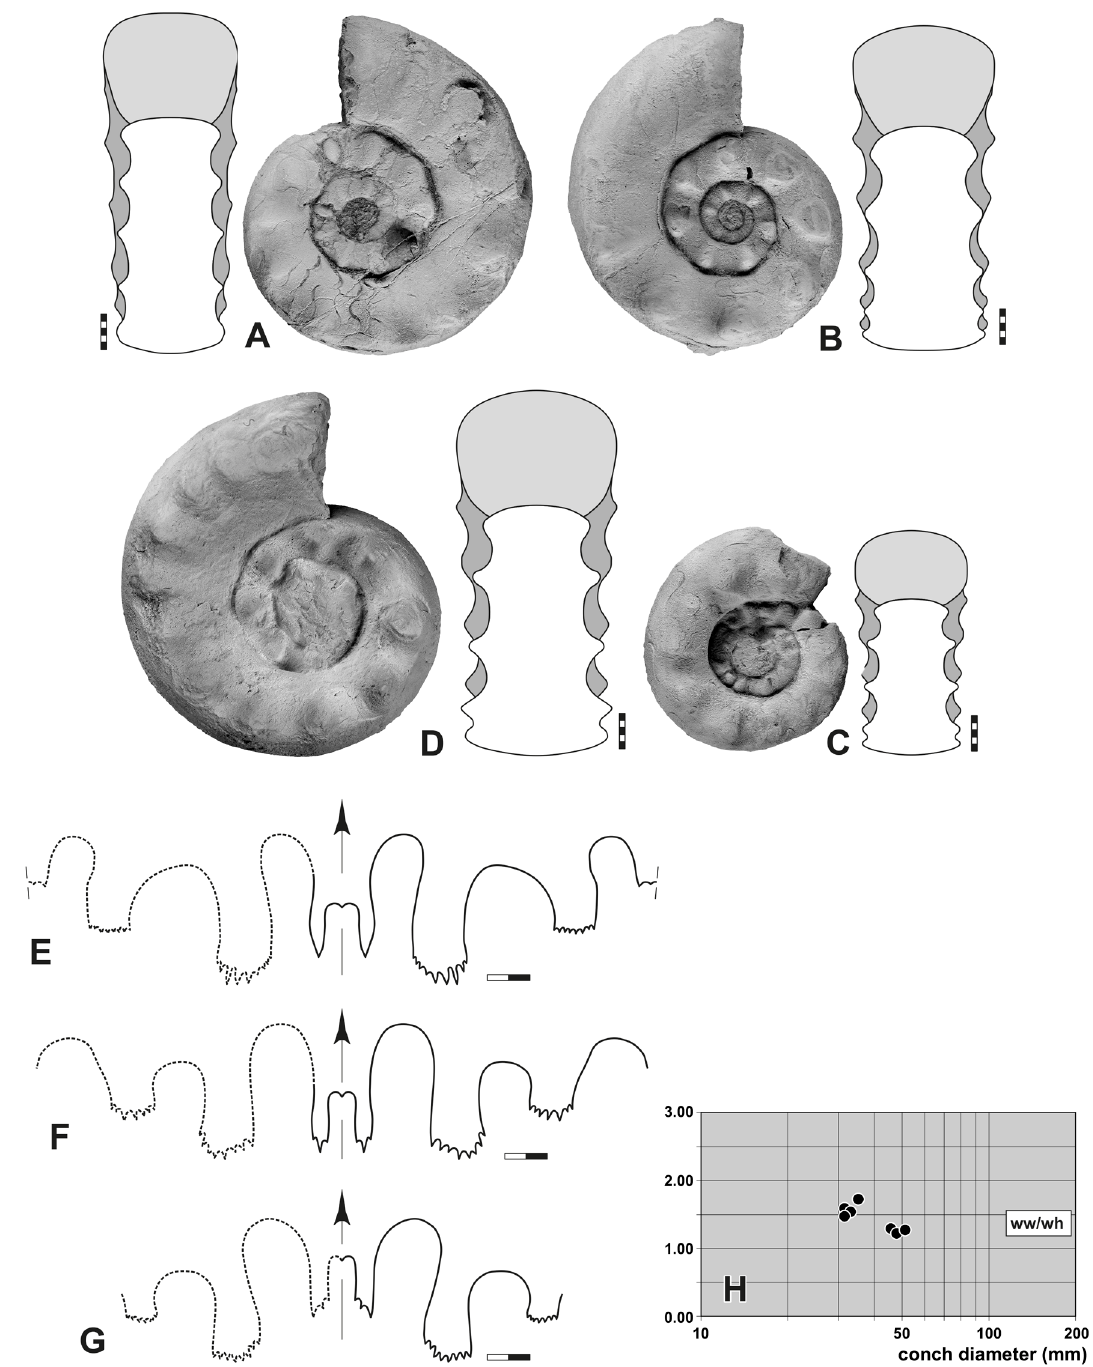
Fig. 22. Dzhulfites spinosus Shevyrev, 1965. A–D . Lateral and dorsal views. A . Specimen MB.C.29741, section E, float. B . Specimen MB.C.29739, float. C . Specimen MB.C.29743, section G, float. D . Specimen MB.C.29744, section H, -5.40 m. E–G . Suture lines. E . Specimen MB.C.29743, at 32.5 mm dm, 16.5 mm ww, 10.5 mm wh. F . Holotype. MB.C.29739, at 32.0 mm dm, 16.0 mm ww, 10.0 mm wh. G . Specimen MB.C.29744, at 29.5 mm dm, 16.5 mm ww, 9.7 mm wh. H . Whorl profile proportions. Abbreviations: see Material and methods. Scale bar units =